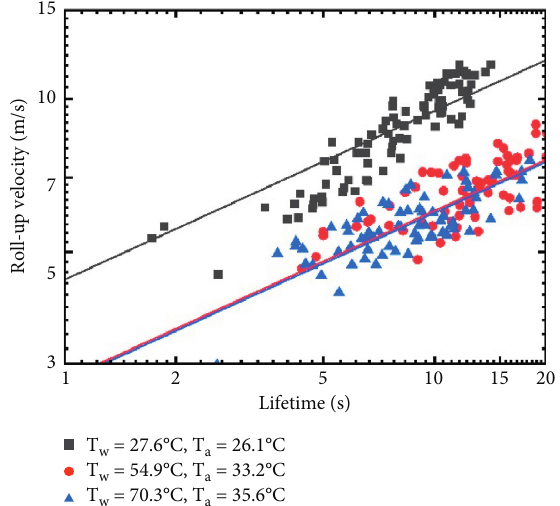
Figure 19: Correspondence between bubble roll-up velocity and lifetime of 0.05g/L TiO 2 aerosol suspension for different conditions.